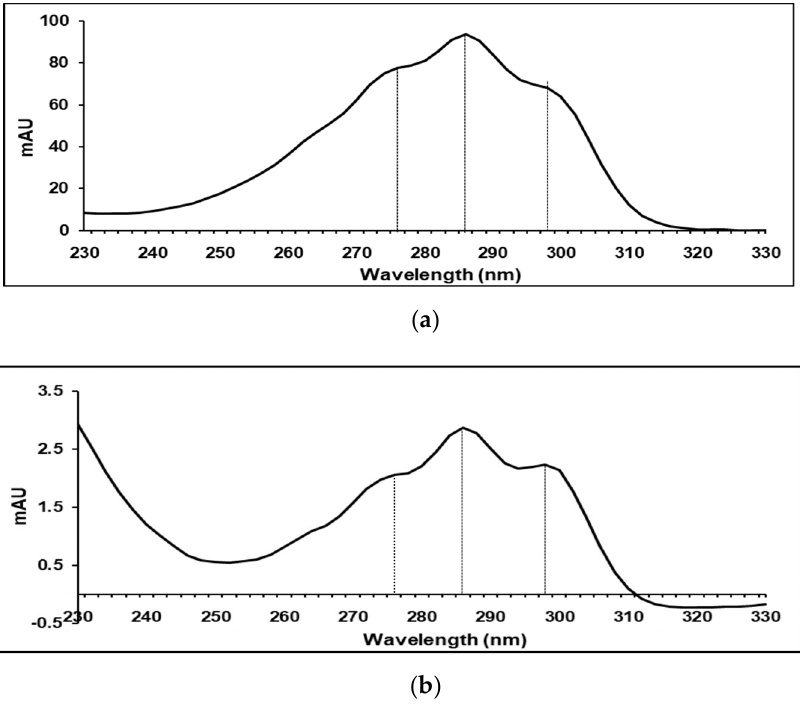
Figure 4 . Absorption spectra of ( a ) 15-cis and ( b ) all-trans phytoene analysed by HPLC-diode array in MeOH/MTBE (8/2) solvent with maximum absorption at 275, 285 and 297 nm.